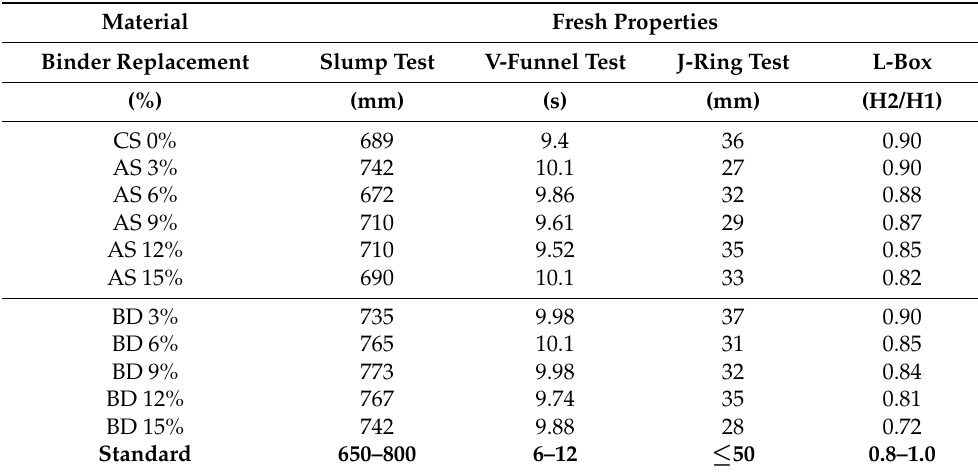
Table 3. Fresh properties of the prepared SCC mixes with Alum Sludge and Brick Dust.